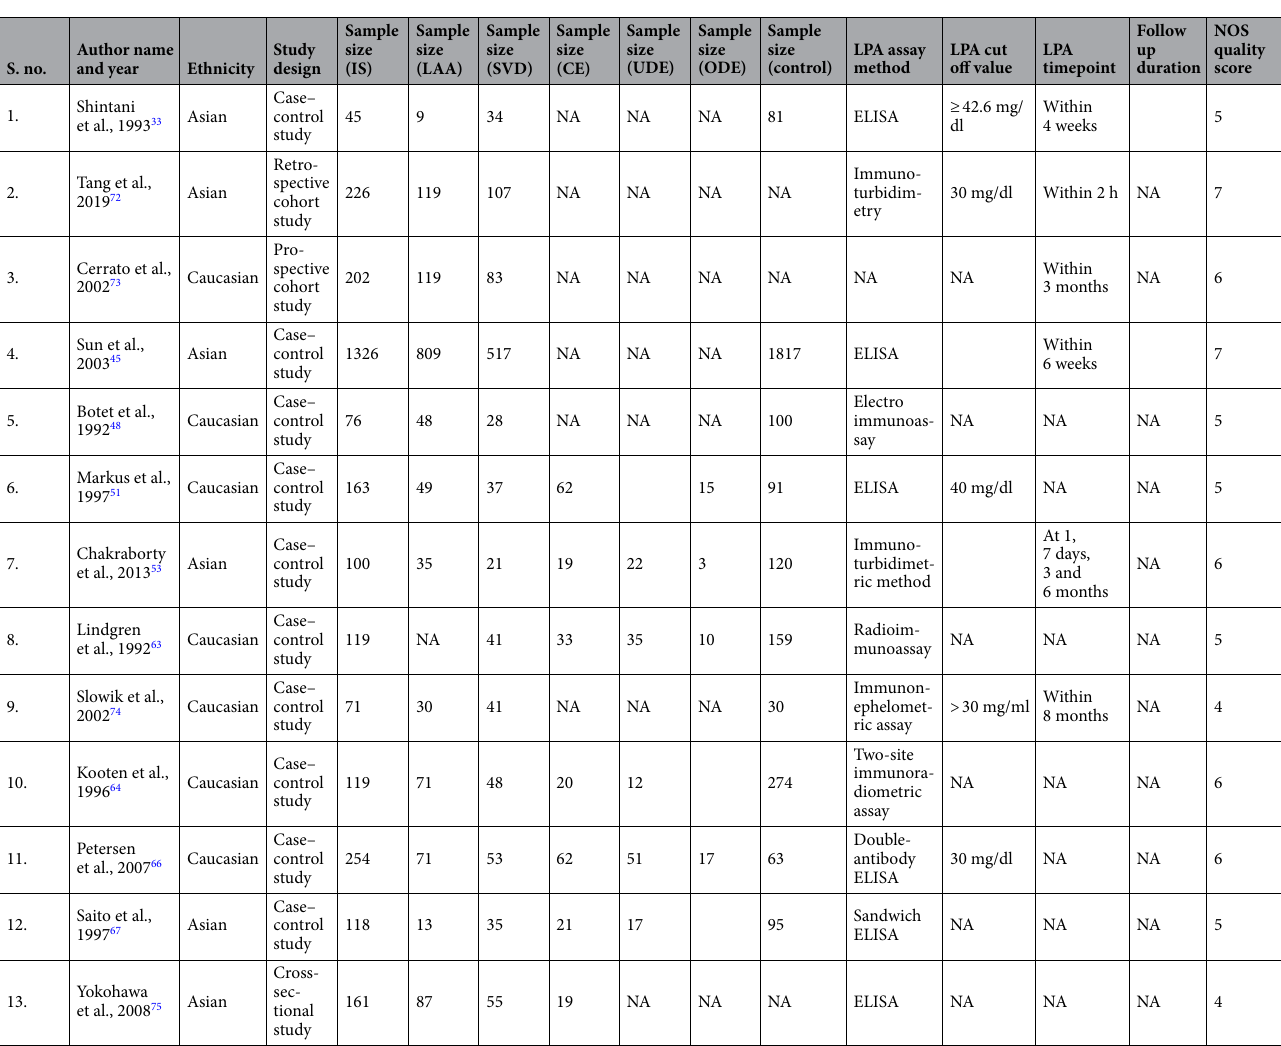
Table 2. Baseline characteristics of studies included in the systematic review and meta-analysis for the relationship between serum Lp(a) levels and risk of ischemic stroke subtypes based on TOAST